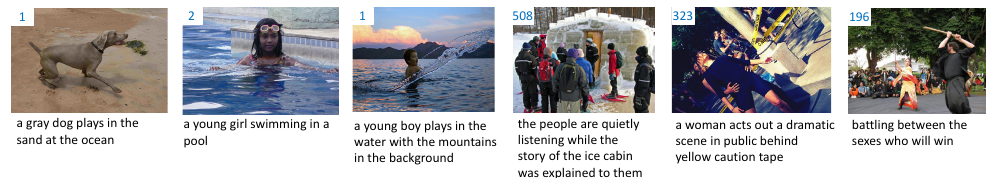
Figure 4. Example results of sentence-based image retrieval. The top left numbers are returned ranks of groundtruth matched